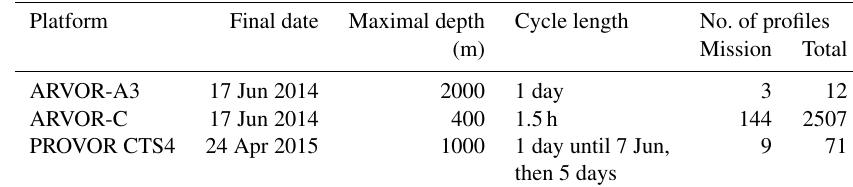
Table 4. Characteristics of the profiling floats.